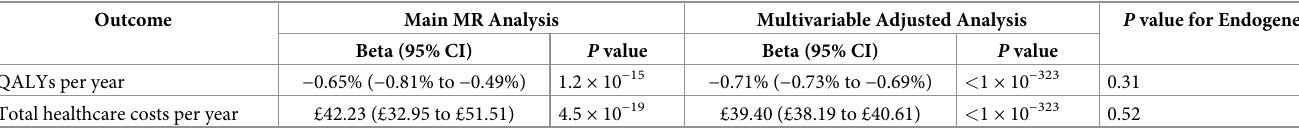
Table 3. Results from the main mendelian randomisation